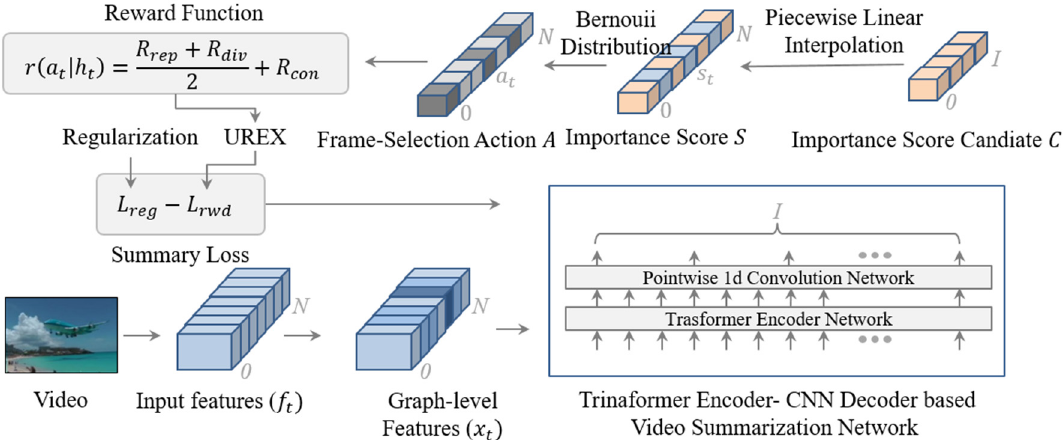
Figure 2. Unsupervised video summarization framework-based on deep reinforcement learning with piecewise linear interpolation.